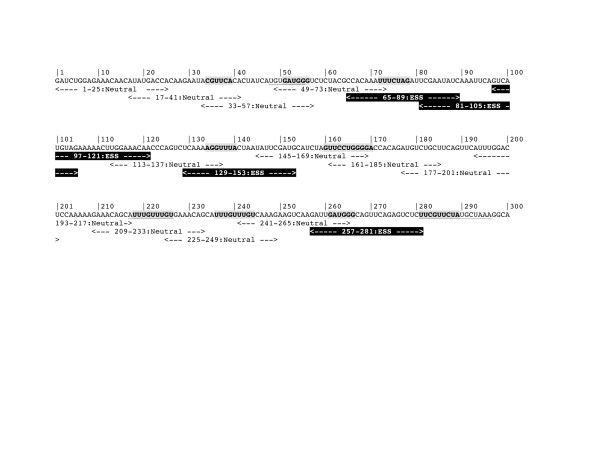
Microarchitecture of ESS activity in exon 26 sequences derived from fragment 6. (A) In vitro splicing assay of DNA ligase III C-ß splicing reporter, tagged with 25-mers derived from fragment 6 (1 hour splicing at 30°C). 10% PAGE shown. Lanes Cß = DNA ligase III C-ß construct without ESS; Cß ex27 1–25 = Cß + nt 1–25 of exon 27; Cß REP = Cß + native ESS; Cß IGF-I ex3 1–25 = Cß + nt 1–25 of exon 3 from IGF-I; DL3 Cß ex 26 lanes = nts of exon 26 tested are shown above each lane; lane 2319–2343 encompasses the RNA editing site and mooring sequence (ED); ED sequence mutations T9A, T9C, A11C, G15C, A19T shown in right-hand five lanes. Adjacent cartoons show identity of bands. (B) Quantification of splicing efficiency, normalised to DNA ligase III C-ß reporter. Bars show splicing efficiency from n=4 experiments with DNA ligase III C-ß = 100%. Error bars show S.E.M. Overall one-way ANOVA shows p <0.0001. Comparison to DNA ligase III C-ß for each construct by Bonferroni’s multiple comparison test: statistically significant differences from efficiency of DNA ligase III C-ß splicing shown by *= p <0.01, **= p <0.001.